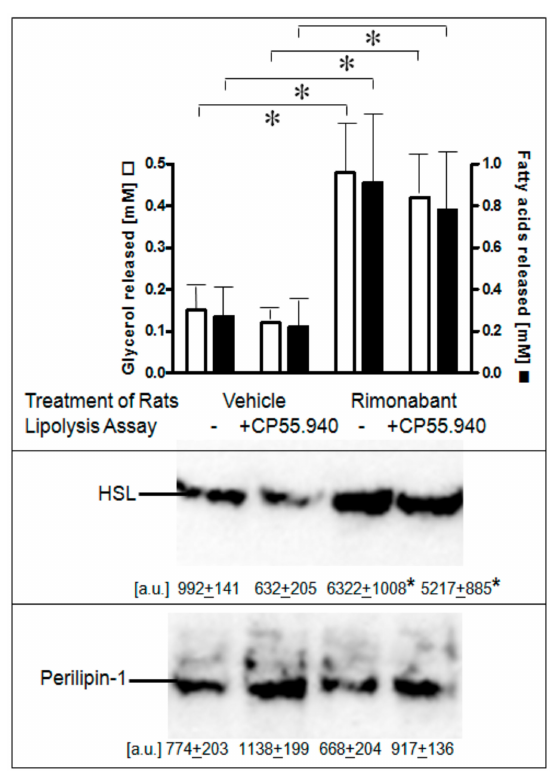
Figure 6. Stimulation of lipolysis in adipocytes from Rimonabant-treated rats. Male Wistar rats (280–320 g) were treated with one dose of Rimonabant (30 mg / kg, p.o.; RIM) or vehicle. After 5 h under free access to food, epididymal adipocytes were prepared by collagenase digestion and washed and then incubated (3 h, 37 ◦ C) in the absence or presence of CP55.940 (10 µ M final conc.). Upper panel: The amounts of glycerol and FA released into the incubation medium were determined enzymatically. Means of determinations in triplicate. Middle and lower panels: The amounts of HSL and perilipin-1 associated with LD, which were prepared from the homogenates of the adipocytes by centrifugation through sucrose cushions, were determined. For this, proteins contained in the top fraction were extracted from lipids, then separated by SDS-PAGE and analyzed for HSL and perilipin-1 by immunoblotting. The images of a typical experiment with electrophoretic runs in quadruplicate with their quantitative evaluations are shown. Mean ± SD of two di ff erent adipocyte / LD preparations with incubations / measurement in quadruplicate. * p ≤ 0.05; no significant di ff erences between absence and presence of